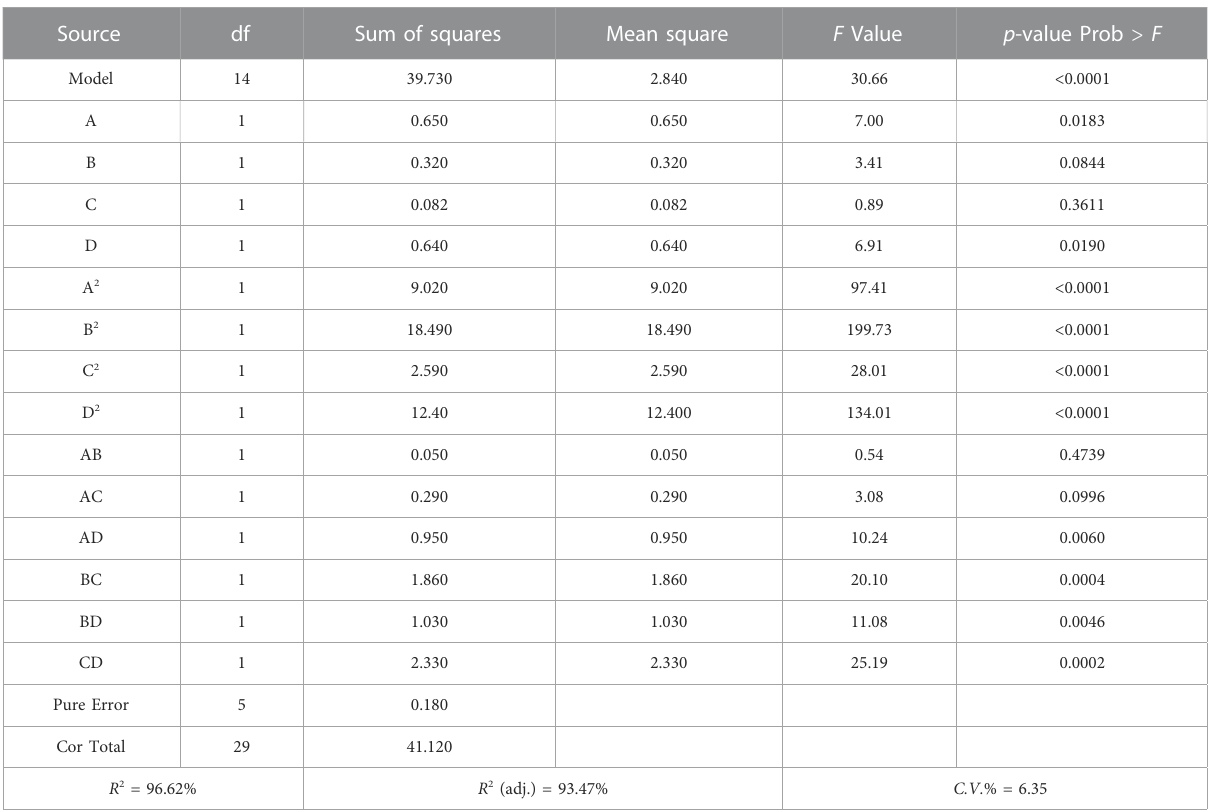
TABLE 4 Analysis of variance of the response surface model. Source df Sum of squares Mean square F Value p -value Prob > F